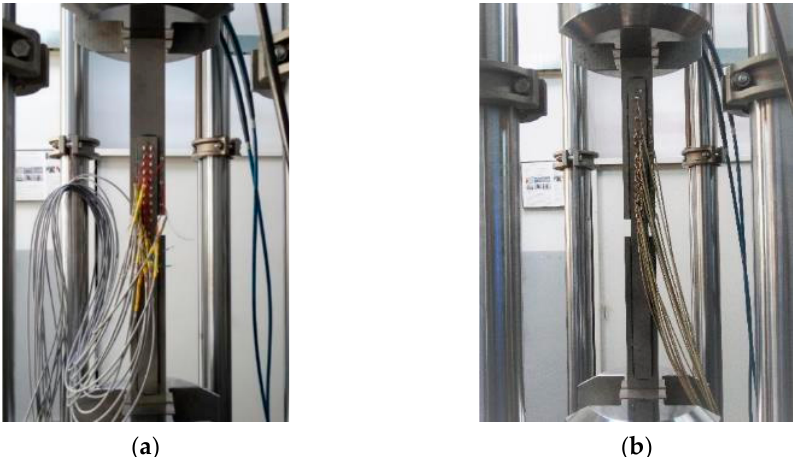
Figure 8. Specimens prepared for tests with a traditional measurement system (strain gauges): ( a ) model with an effective length of 200 mm; ( b ) model with an effective anchorage length of 400 mm.